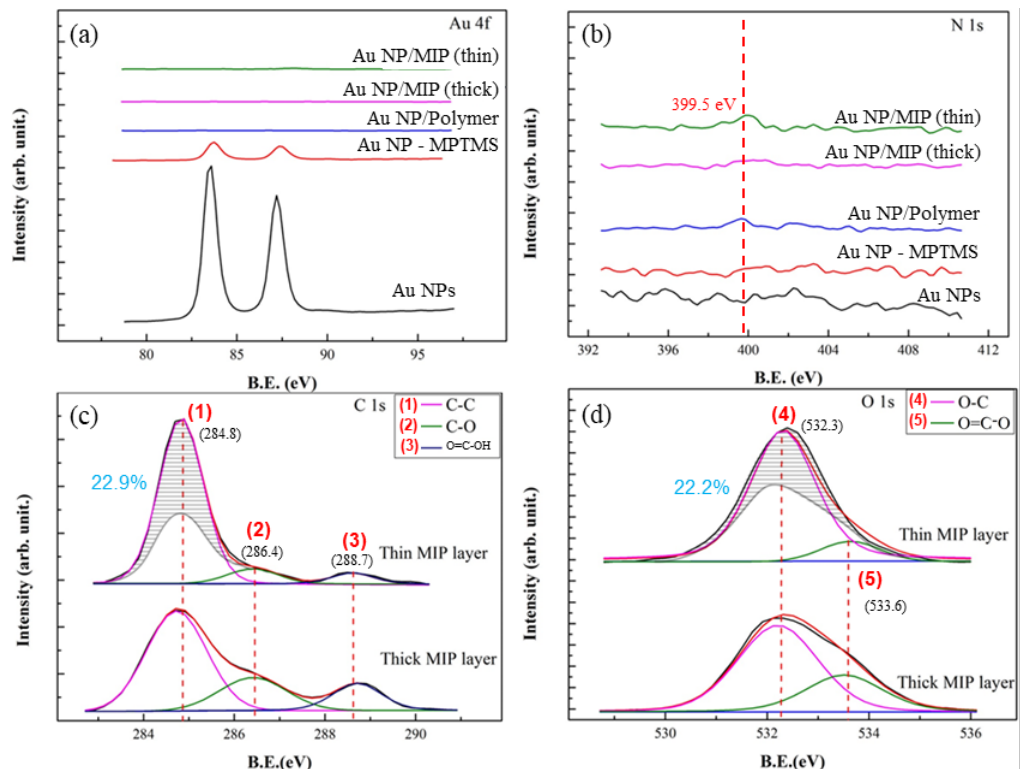
Figure 3. XPS spectra of the Au and Au NP/MIPs to analyze the present elements and groups in each step along the fabrication process. ( a ) spectra of the substrates corresponding to Au; ( b ) spectra of the substrates corresponding to N; ( c , d ) comparisons of the spectra of the Au NP/MIPs with thick and thin layer with respect to functional groups of C and O.